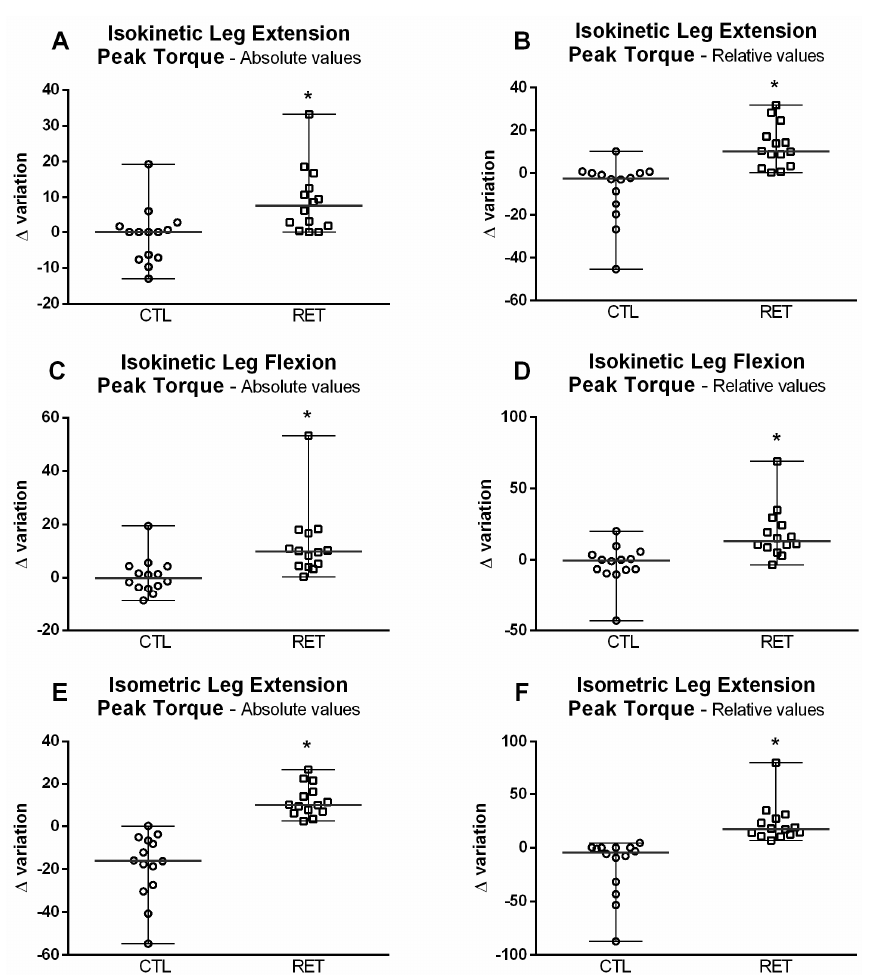
Figure 4. Isokinetic/isometric PT evaluation. ( A )—Delta variation isokinetic leg extension PT values. ( B )—Delta variation isokinetic leg extension PT/body mass values; ( C )—Delta variation isokinetic leg flexion PT values. ( D )—delta variation isokinetic leg flexion PT/body mass values. ( E )—delta variation isometric leg extension PT values. ( F )—delta variation isometric leg extension PT/body mass values. PT: Peak torque. * Different from CTL, p < 0.05.